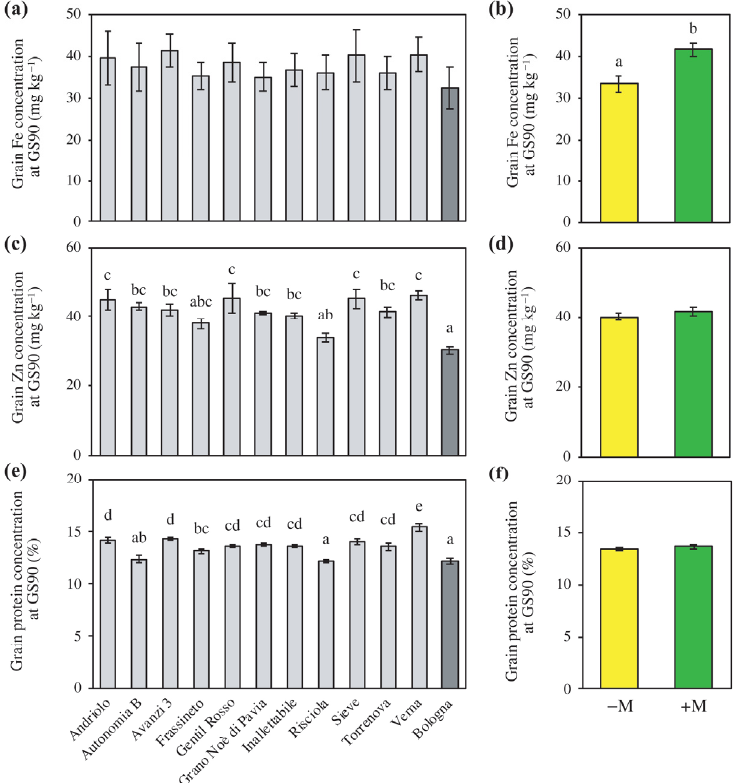
Figure 6. E ff ects of wheat genotype and AMF inoculation on grain Fe concentration ( a , b ), grain Zn Figure 6. Effects of wheat genotype and AMF inoculation on grain Fe concentration ( a,b ), grain Zn concentration ( c , d ) and grain protein concentration at GS90 ( e , f ). AMF inoculation and mock control concentration ( c,d ) and grain protein concentration at GS90 ( e,f ). AMF inoculation and mock control are indicated as + M and − M, are indicated as +M and –M, respectively.